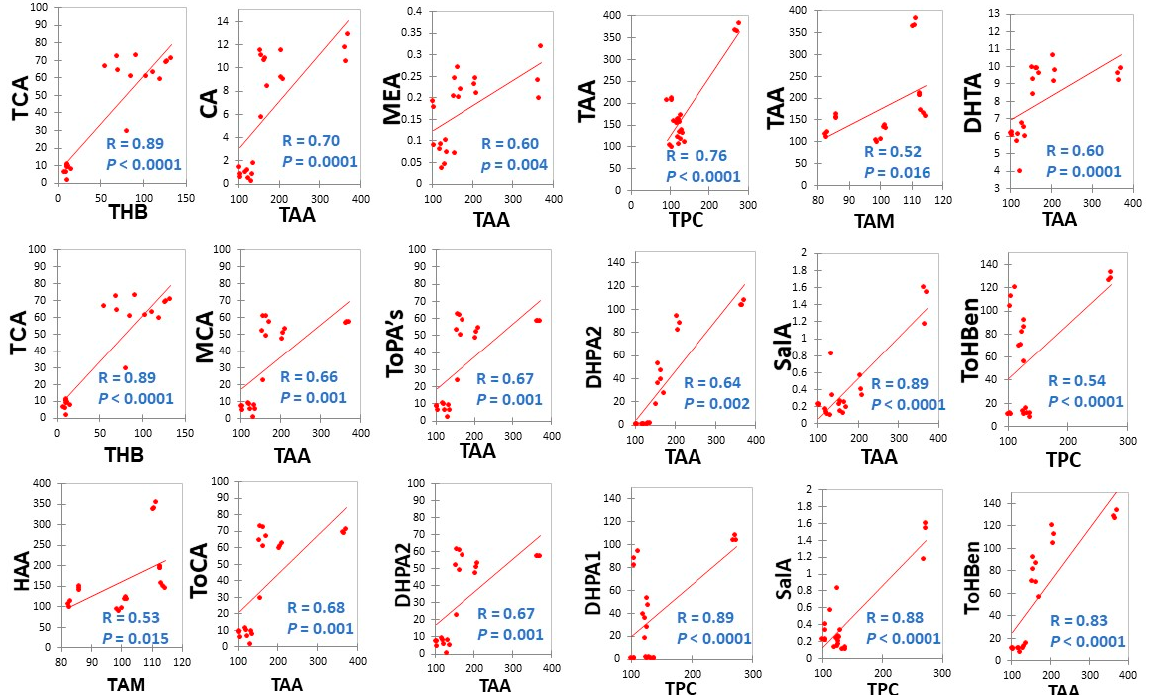
Figure 3. Correlation between TAA and CA, TAA and MEA, TAA and TPC, TAA and TAM, DHTA and TAA, MCA and TAA, ToPA’s and TAA, DHPA2 and TAA, SalA and TA, ToHBen and TPC, ToCA and TAA, DHPA2 and TAA, DHPA1 and TPC, SalA and TPC, ToHBen and TAA content. HAA = hydrophilic antioxidant activity, LAA = lipophilic antioxidant activity, TAA = total antioxidant activity, HPC = hydrophilic phenolic content, LPC = lipophilic phenolic content, TPC = total phenolic content. TAM = total antioxidant minerals, ToHBen = total hydroxybenzoic acids, ToPA’s = total other phenolic acids. ToCA = total cinnamic acids. DHPA1 = 3,4-dihydroxybenzaldehyde, DHPA2 = 3,4-dihydroxybenzalacetone, SalA = Salicylic acid, DHTA = dihydroxyterephtalic acid, MEA = methyl-gallic acid, CA = caffeic acid. Antioxidant activity was expressed as µmol Trolox equivalent/g extract of Chaga and phenolic content was expressed as µmol quercetin equiv- alent/g extract of Chaga. R-values represent Pearson correlation coefficients, p = 0.05, n = 4 per replicate of each sample at various pH values and temperatures.